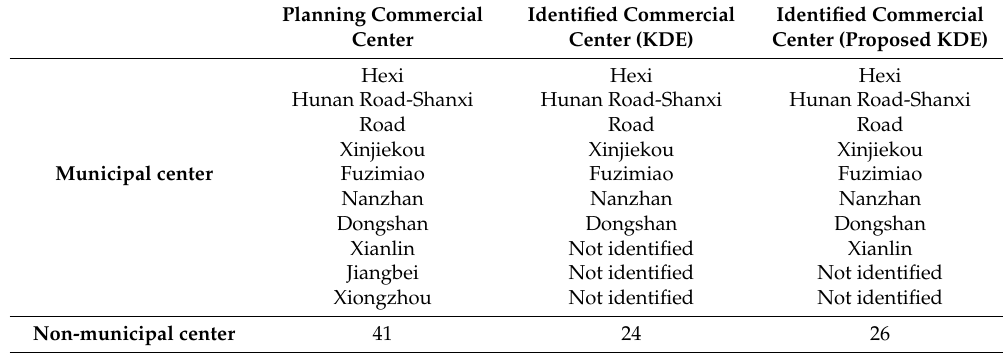
Table 6. Identification results of urban commercial central districts.